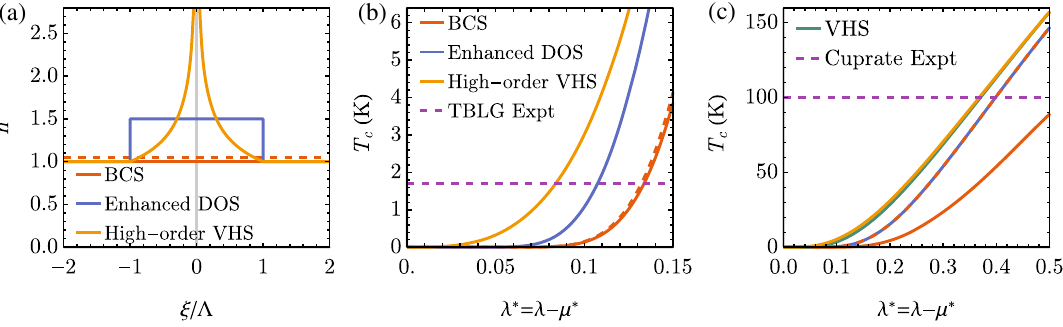
FIG. 8. (a) Schematic plot of the DOS in different scenarios ( ν ¼ − 1 = 3 for the high-order VHS scenario). The rescaled DOS in the 10 Λ (see text for definition). (b),(c) Transition temperature T BCS scenario is plotted with a red dashed line with ϵ D ¼ retarded interaction λ (cid:1) ¼ λ − μ (cid:1) with parameters relevant to (b) twisted bilayer graphene (TBLG) and (c) cuprate superconductor. The red dashed line represents using rescaled DOS in the BCS scenario. Detailed description for each line is in the text. In (b), we pick ϵ 230 meV, Λ ¼ 5 meV, ν ¼ − 1 = 3 . In (c), we pick ϵ 50 meV, Λ ¼ 50 meV, ν ¼ − 1 = 4 D ¼ D ¼